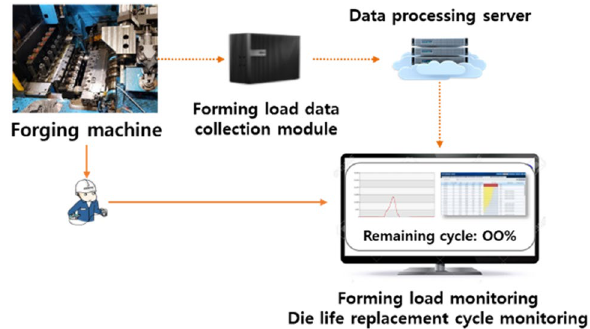
Figure 17. Die life managing